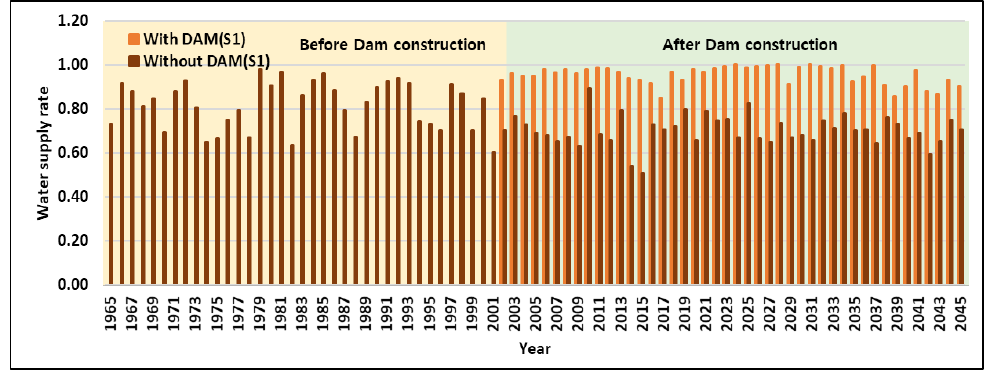
Figure 13. Water supply rate comparison between the With DAM and Without DAM simulations for Scenario 1.